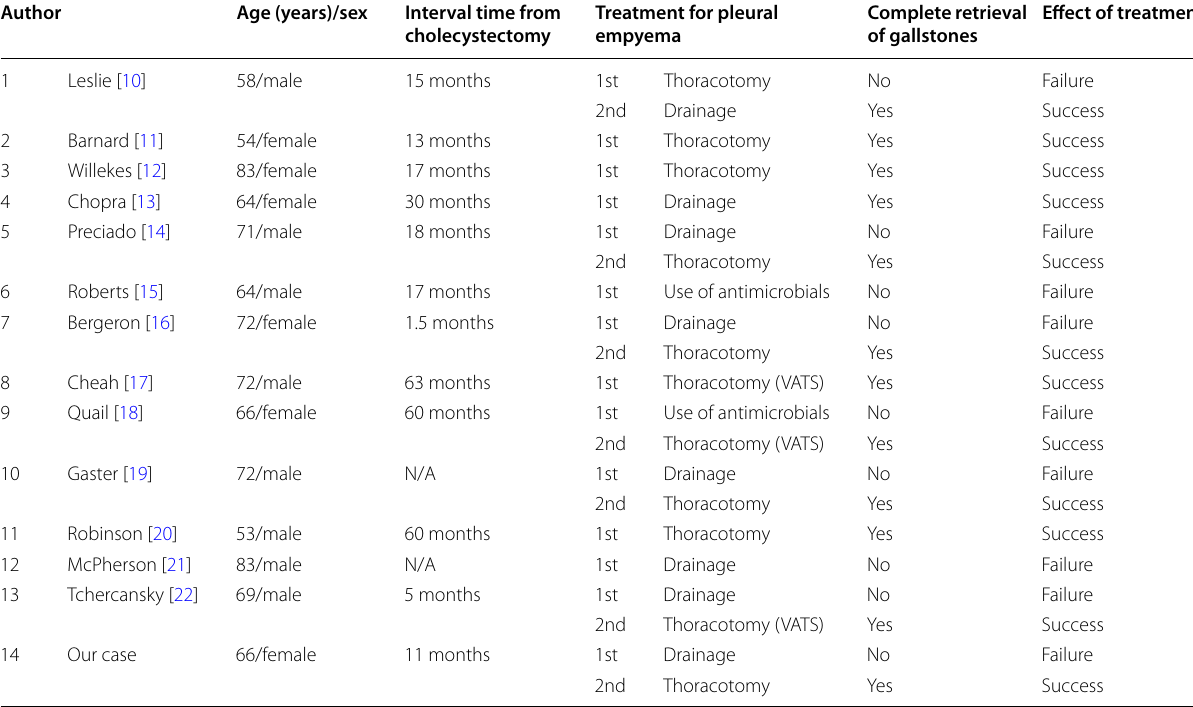
VATS video-assisted thoracic surgery, N/A not